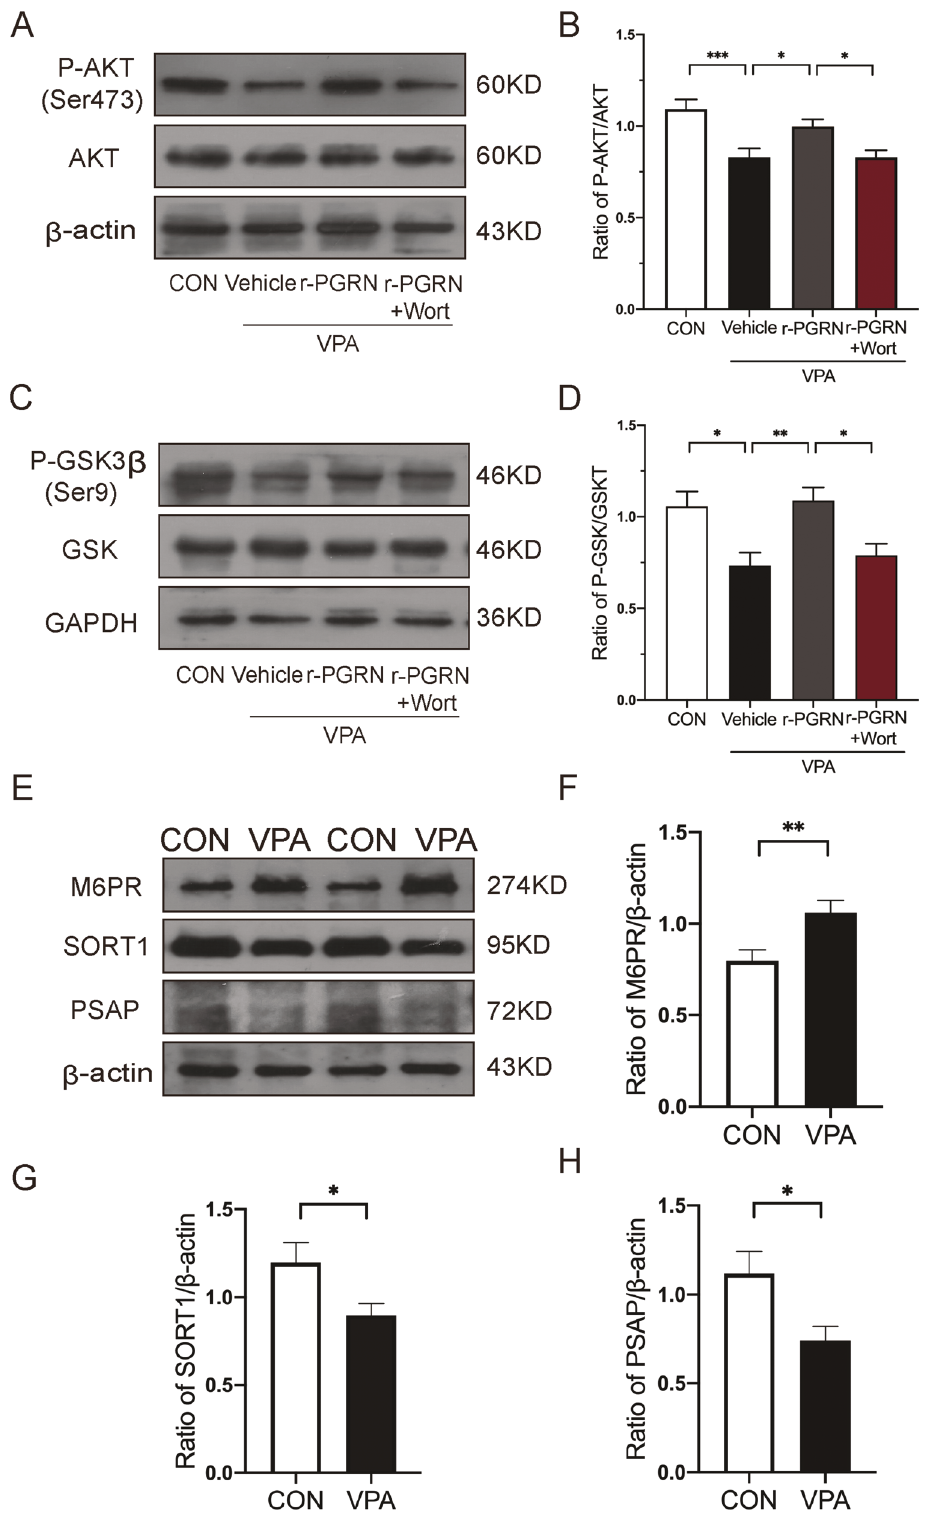
Fig. 6 PGRN activated PI3K/Akt/GSK-3 β signalling pathway and the expression of M6PR, SORT1 and PSAP in VPA-induced rats at PND35. Representative Western blots ( A , C ) and densitometric quanti fi cation ( B , D ) of p-Akt (Ser473), Akt, p-GSK-3 β (Ser9) and GSK-3 β expressions in the cerebellum. Representative Western blots ( E ) and densitometric quanti fi cation ( F – H ) of M6PR, SORT1 and PSAP. Data are expressed as mean ± SEM. One-way ANOVA followed by Tukey ’ s post hoc ( B , D ); Student ’ s t test ( F , H ); Mann – Whitney test ( G ). (* P < 0.05, ** P < 0.01, *** P < 0.001, sample sizes ( n ): n =